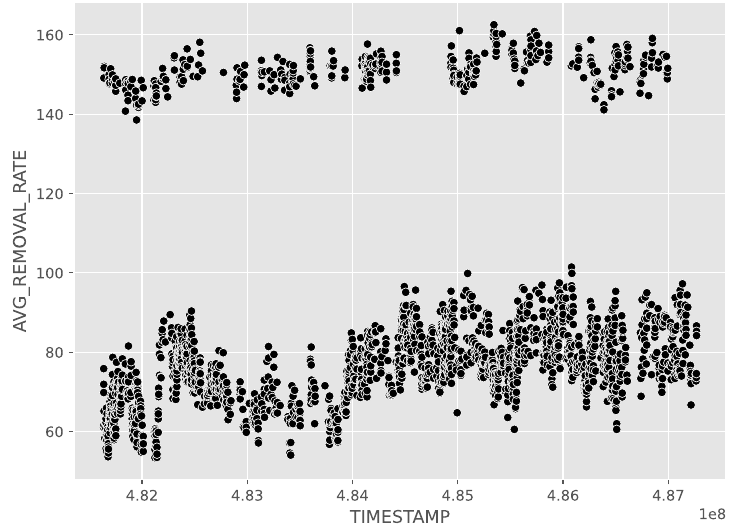
Figure 2. Removal Rate